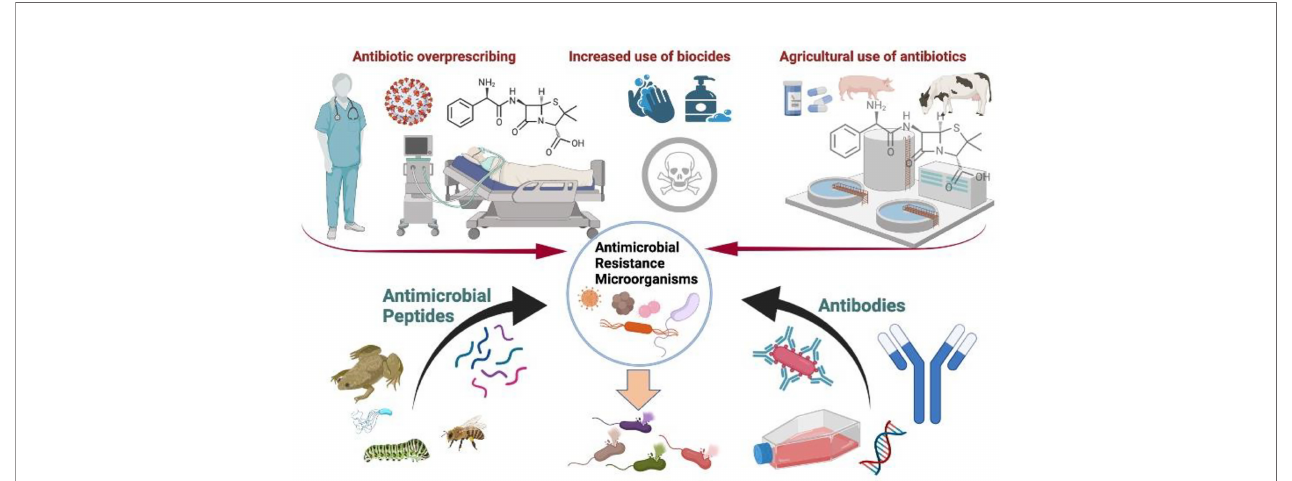
FIGURE 5 | In the current COVID-19 scenario, antibody-based treatments such as pathogen-speci fi c monoclonal antibodies (MAbs) and antimicrobial peptides (AMPs) could limit the development of resistant microorganisms as they are considered to generate little or no